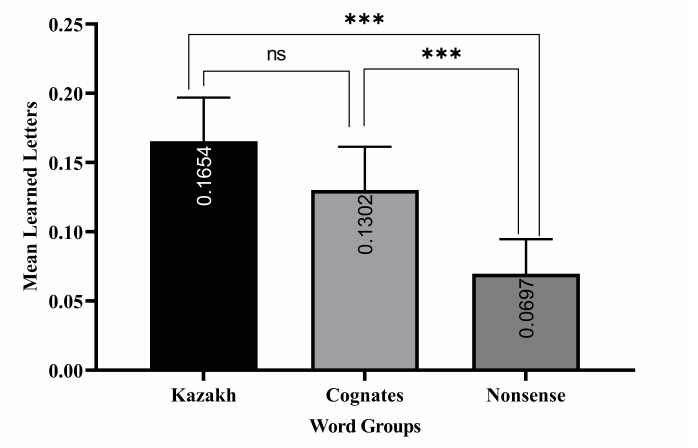
Figure 2. Mean values of learned letters by word categories in Experiment 2. p -values larger than 0.05 are summarized as “ns” (not significant), while p -values less than 0.001 are given three asterisks (***) to denote significance, as shown in the Wilcoxon